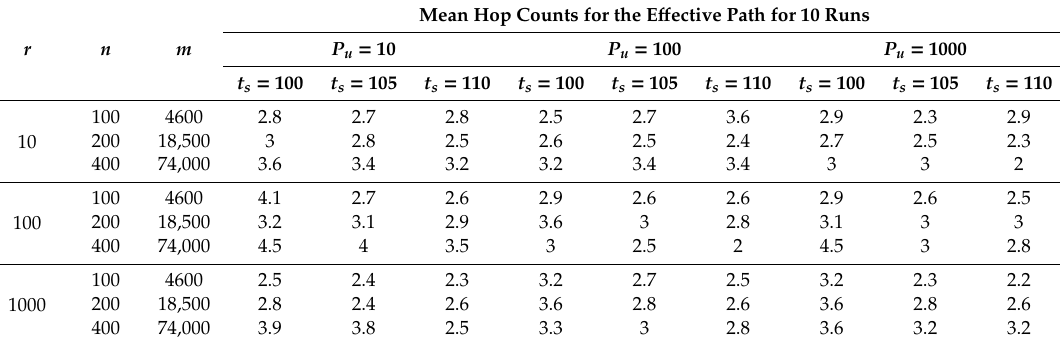
Table 3. Mean hop counts for the e ff ective path for the SESE algorithm for 1 Mb . Mean Hop Counts for the E ff ective Path for 10 r n m